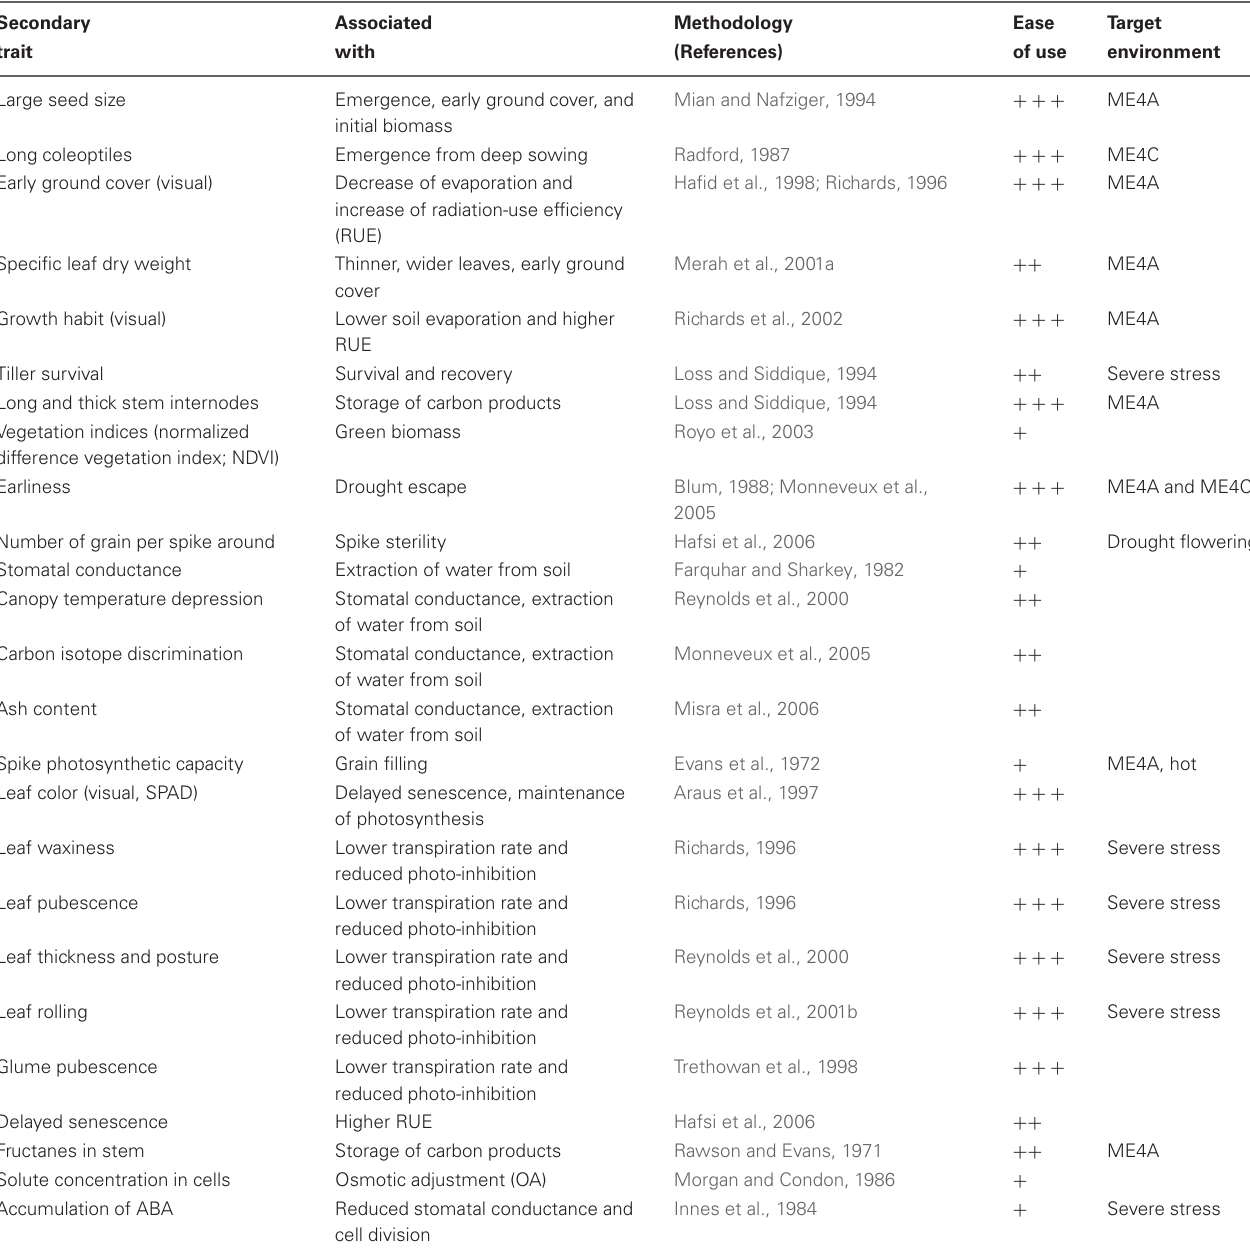
Table 3 | Main secondary traits that can be used to improve drought tolerance in wheat, associated mechanisms, references, ease of use, and target mega-environment of application (Adapted from Reynolds et al.,